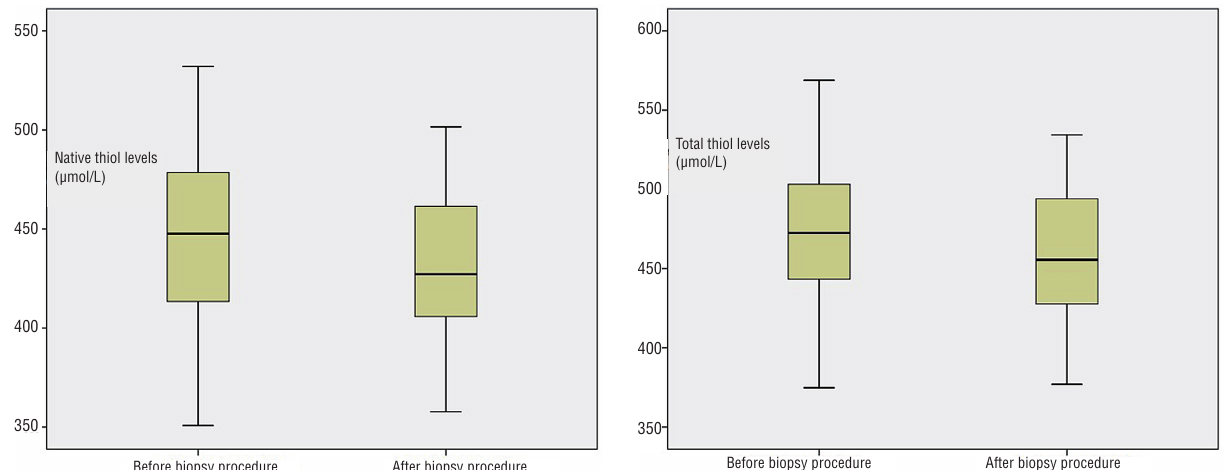
figure 2 - Total thiol levels were significantly lower in men who underwent transrectal ultrasound guided prostate biopsy when compared to the levels just before biopsy (p=0.03, paired samples